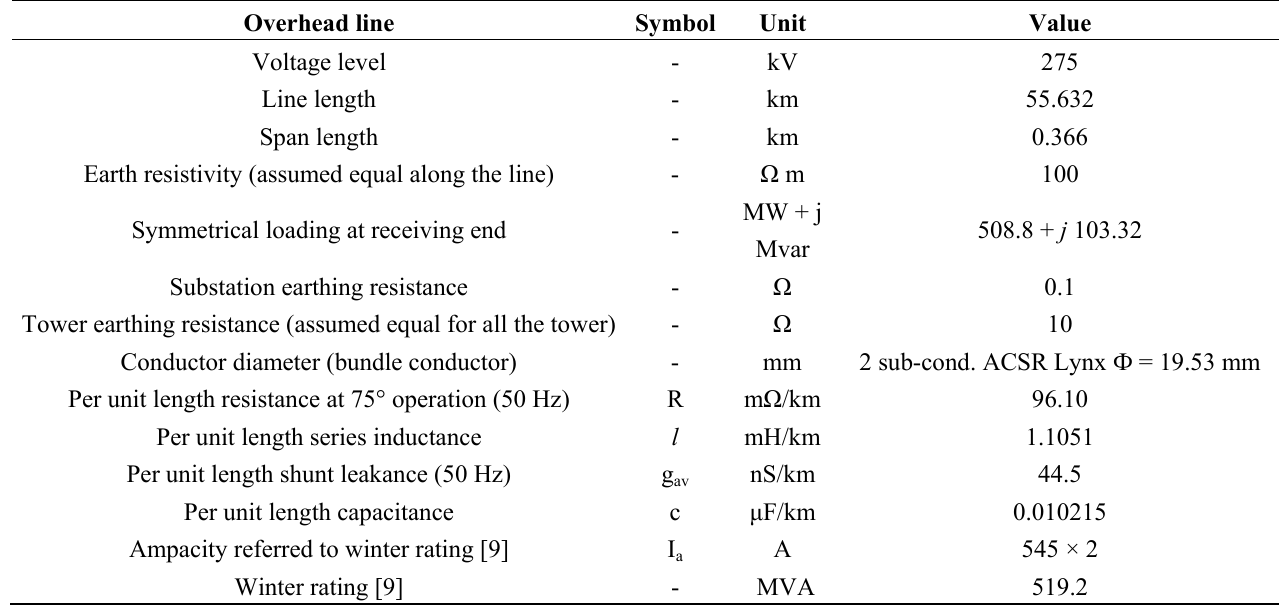
Table 1. OHL geometrical and electrical characteristics.